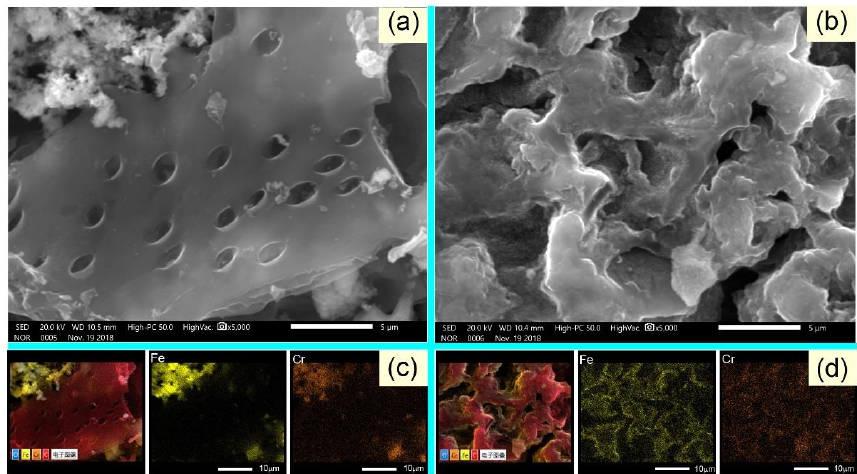
Figure 6. The SEM microscopic images of Cr(VI) adsorbed on nZVI – BC ( a ) and C – nZVI – BC ( b ). Scale bar = 5 µm. The energy-dispersive X-ray spectroscopy (EDS) element mapping of Fe (yellow) and